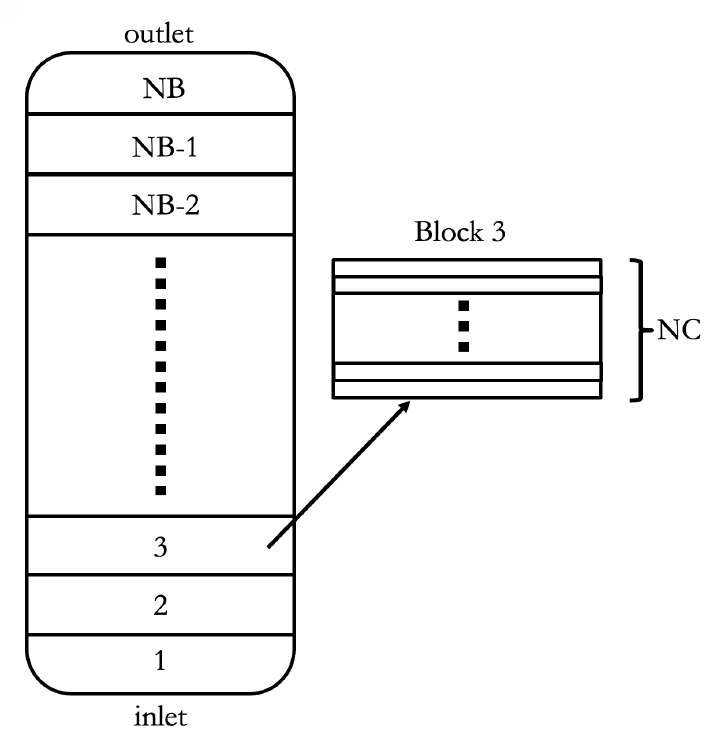
Figure 2. Division of the subchannel assembly into